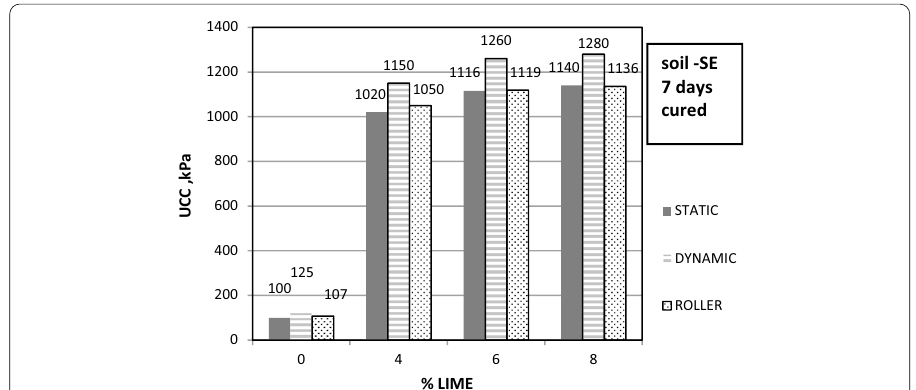
Fig. 7 Effect of lime on UCS of soil SE compacted by different methods of compaction cured for 7 days